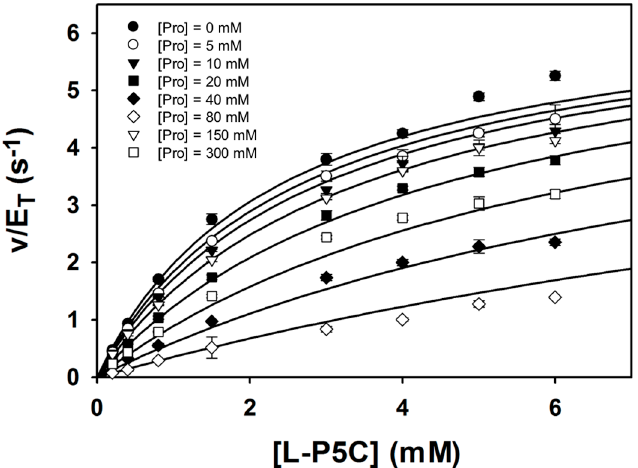
Figure 6. Kinetic data showing that proline is a competitive inhibitor of the GSALDH activity of BjPutA. Initial velocity pattern for BjPutA mutant R456M (0.25 μ M) as a function of P5C concentration at 8 different fixed proline concentrations. The curves represent a global fit of the data to a competitive inhibition model. Best fit parameters were K m = 2.4 ± 0.1 mM, k cat = 6.7 ± 0.1 s − 1 , and K i = 46.3 ± 1.7 mM proline.